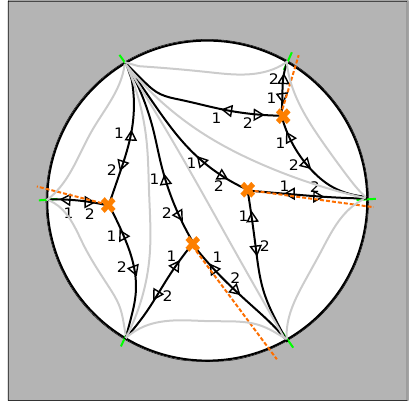
Figure 45 . The WKB foliation at some point in the Coulomb branch of the ( A 1 ; A 3 ) Argyres- Douglas theory. Here the irregular singularity is placed at z = 1 . The green markers on the boundary circle correspond to P i , which are determined by the six rays going into the irregular